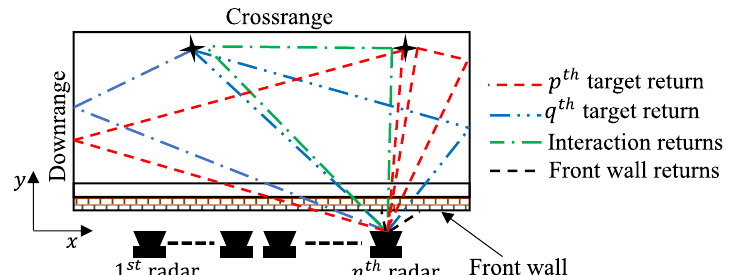
Fig. 1 Signal model for through-the-wall radar